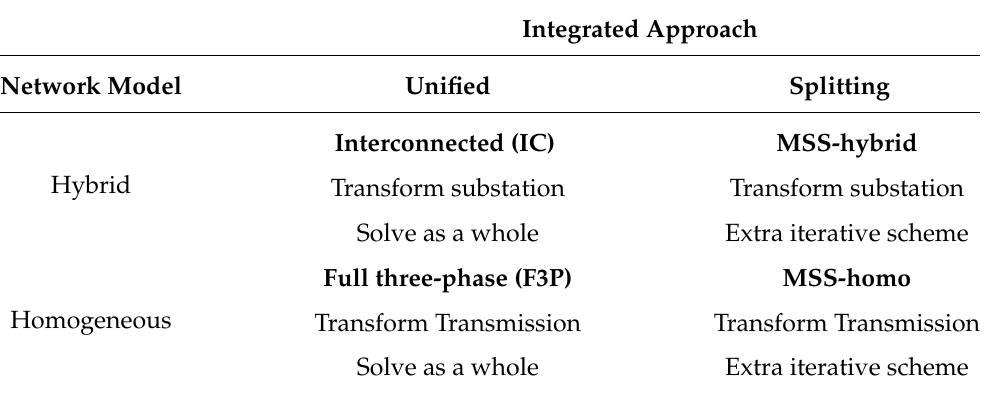
Table 2. Classification of numerical methods to solve integrated